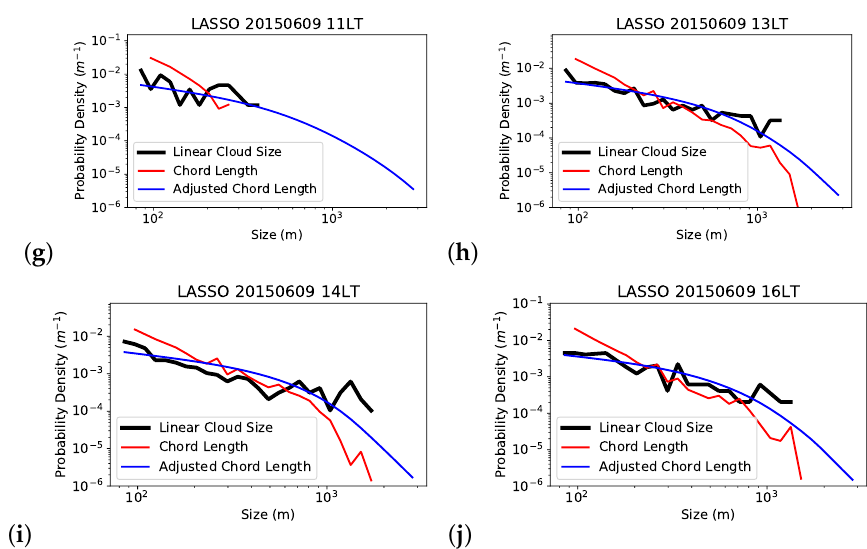
Figure 8. Reconstructed linear cloud size distributions for different cases, with the linear cloud size (black), the chord length distribution (red), and the adjusted chord length distribution (blue). ( a ) BOMEX 8th hour. ( b – d ) RICO hr 8, 24, and 48. ( e – f ) ARM 12LT and 16LT. ( g – j ) LASSO 11, 13, 14, and 16